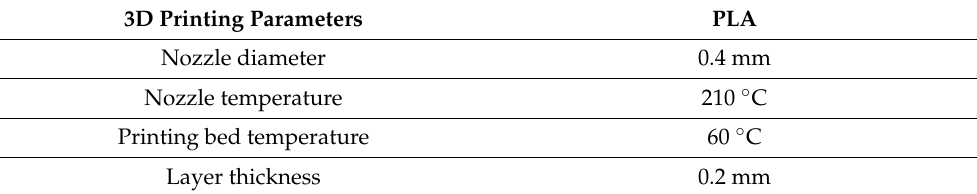
Table 1. The 3D printing